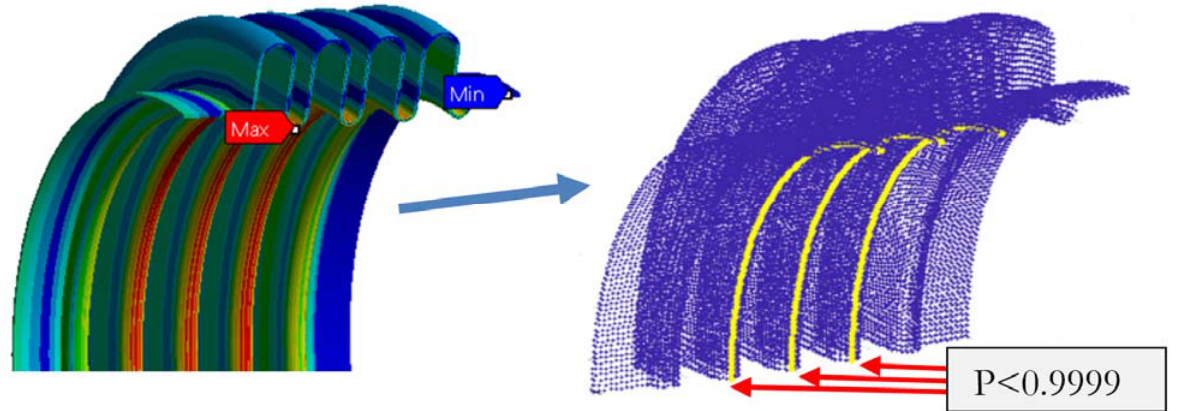
Figure 10: Nodal reliability assessment by FE model in